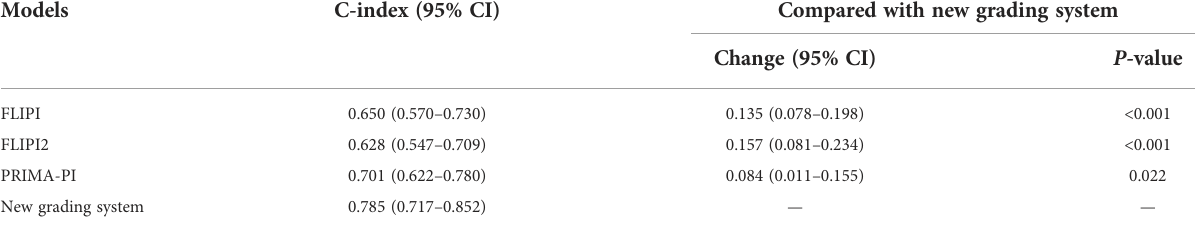
TABLE 4 Comparative analysis of model performance for PFS between the new grading system and existing prognostic indexes.